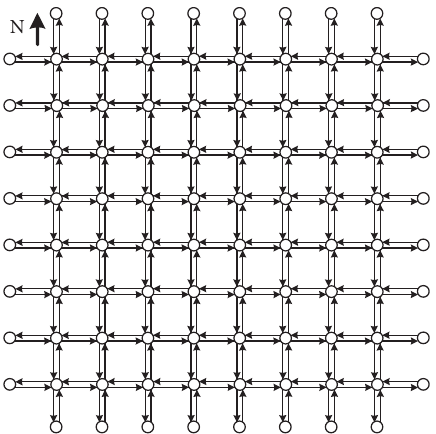
Figure 6: An 8 × 8 two-way grid network. All boundary nodes are both origins and